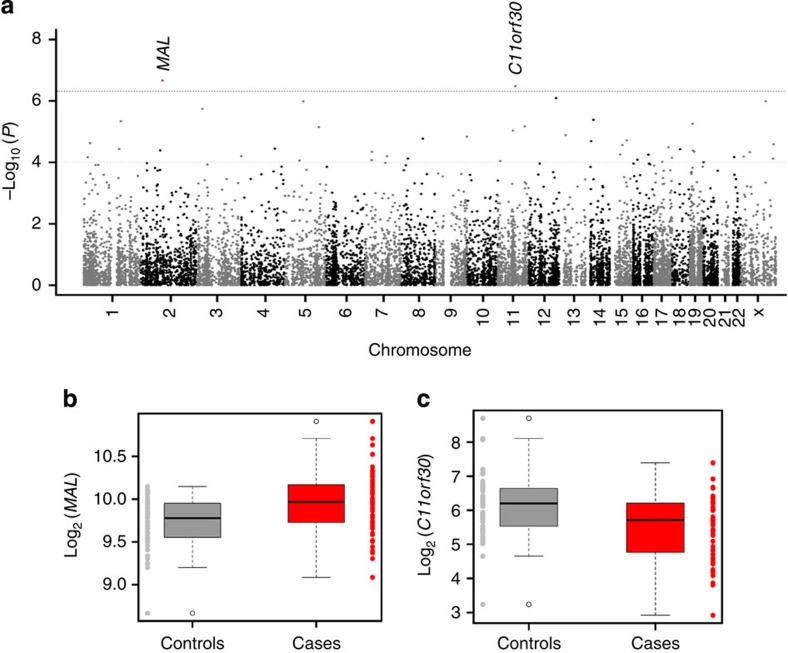
Single-gene expression analysis identifies two transcriptome-wide significantly differentially expressed genes between autism and control brains.(a) Manhattan plot for 13,262 expressed genes. The threshold for transcriptome-wide significance was calculated based on 400 permutations (P<4.76 × 10−7) and is indicated by the dotted grey line. (b,c) Boxplot of gene expression in 57 controls (grey) and 47 cases (red), indicating a 1.2-fold increase for MAL and a 0.6-fold decrease for C11orf30 in cases relative to controls.